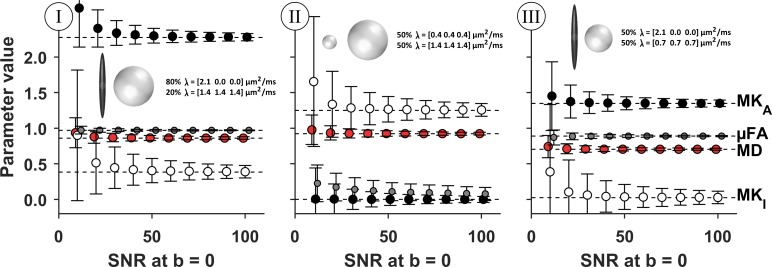
Simulation of DIVIDE parameter accuracy and precision in three model tissues.Markers show the mean parameter value, and the whiskers show one standard deviation across 104 independent realizations of noise. The dashed horizontal lines show the parameter values that are estimated for a noise-free signal; deviation from the line indicates parameter bias caused by noise. As expected, precision and accuracy both improve with increasing SNR. The estimation of MD and μFA appear to be the most accurate and precise, although the μFA shows a deterioration of accuracy and precision when its true value is low (panel II) [19]. Both MKA and MKI suffer a positive bias when SNR in the b = 0 image is approximately 20 or less. Interestingly, MKA is always more precise and accurate than MKI, indicating that it is generally less sensitive to noise. The simulations show that signal noise can cause negative values for both MKI and MKA, which is especially likely when the true values are close to zero. Finally, in the case where MKI = 0 (panel III), signal noise did not cause a strong positive bias in MKI for SNR levels that match configuration C (where the majority of voxels have SNR > 20 at b = 0.1 ms/μm2, Fig 3). This suggests that signal noise alone is not likely to explain the positive MKI that is observed throughout the brain parenchyma.